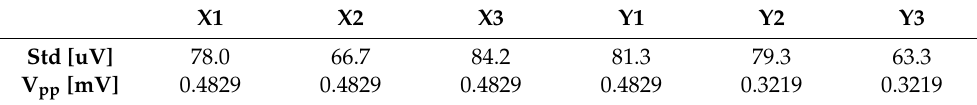
Table 2. Results with median filter.